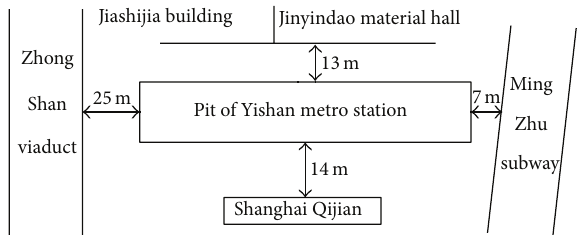
Figure 1: Layout of Yishan metro